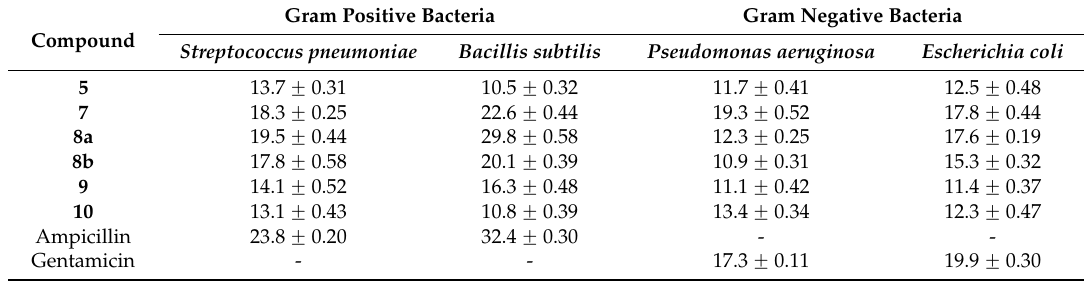
Table 1. Antibacterial activity of the synthesized thiophene derivatives 5 , 7 , 8a – b , 9 and 10 .